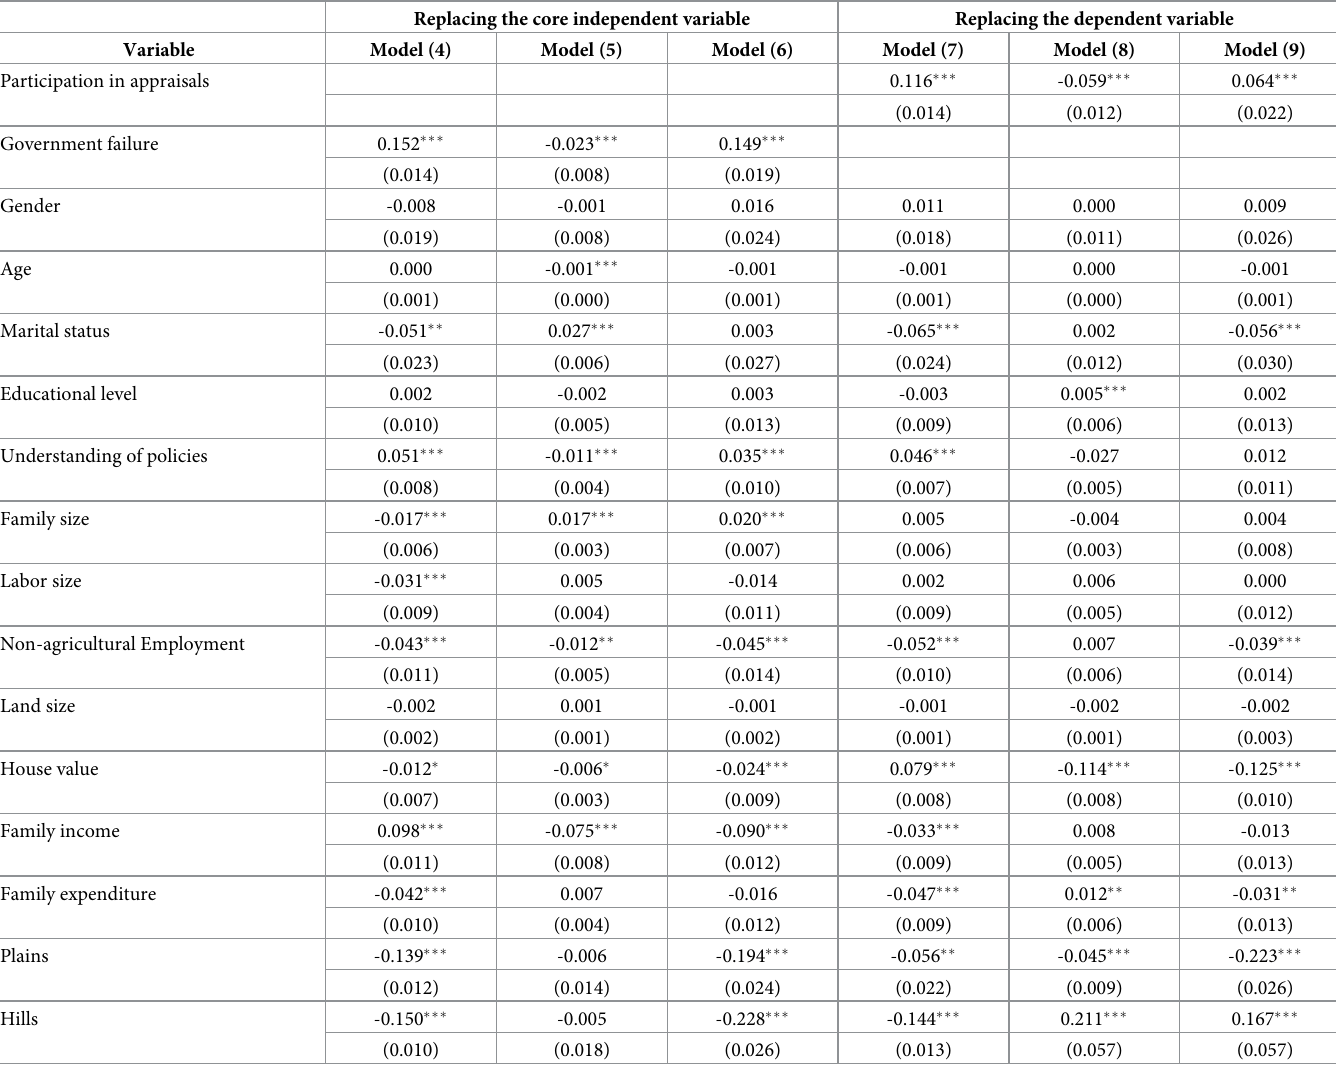
Table 4. Robustness test